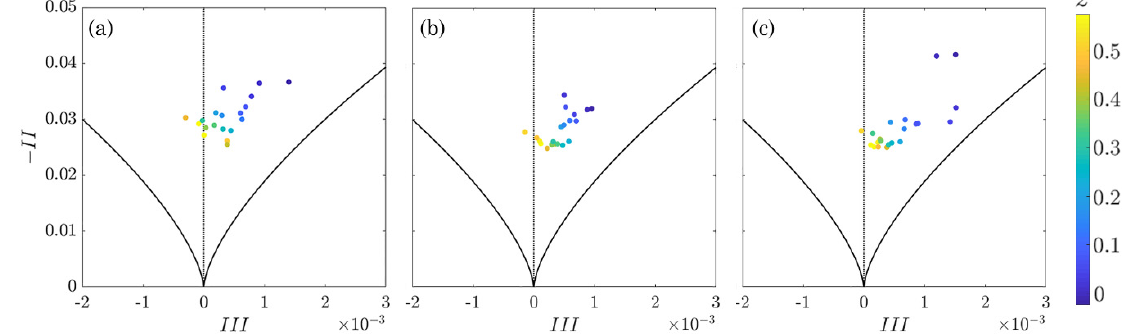
Figure 10. AIMs of the undisturbed flow condition for ( a ) Run 1, ( b ) Run 2, and ( c ) Run 3.